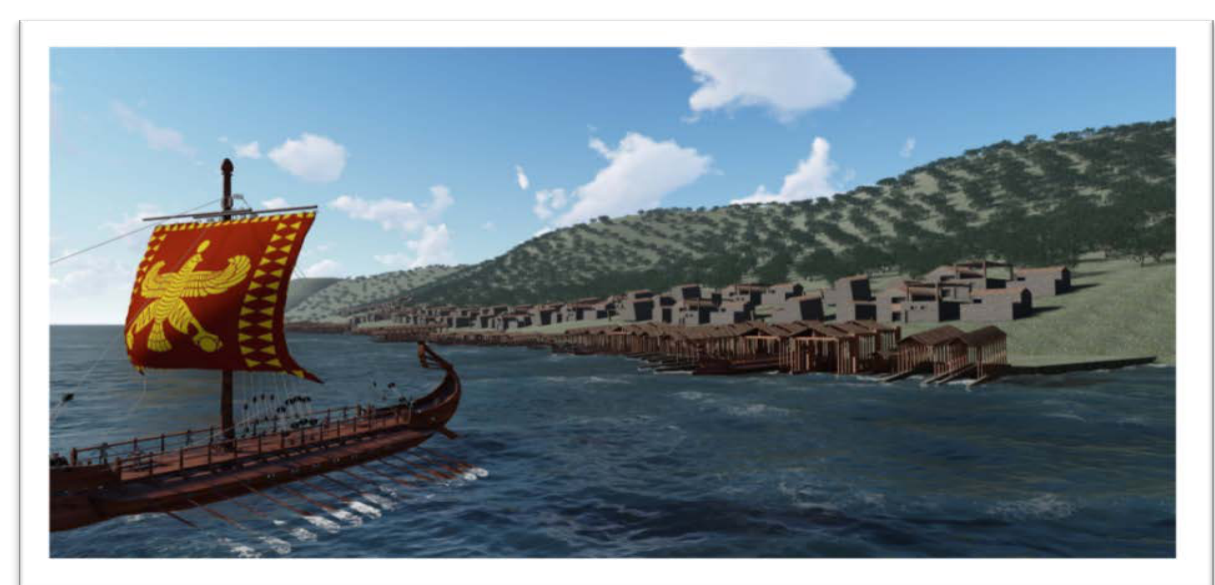
Figure 13 Persian warships during Lade Island naval